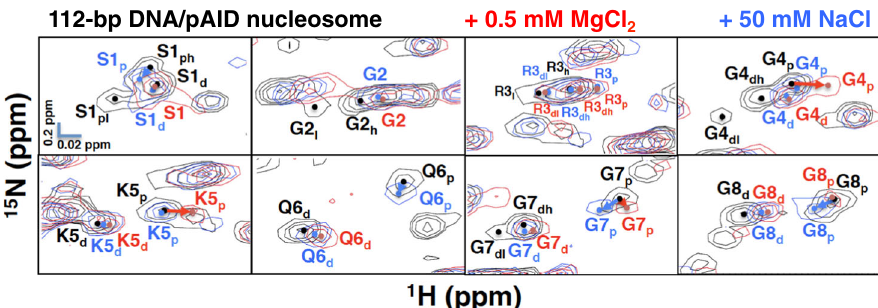
Fig. 7 Conformational comparison of the H2A N-tail upon metal ion titration. Expanded signal comparison of the H2A N-tail in the 112-bp DNA/pAID nucleosome at 0 M (black), 0.5 mM MgCl 2 (red), and 50 mM NaCl (blue). NMR signals are divided into panels by each amino acid residue, Ser1 – Gly8 of H2A. Signal assignments in the 112-bp DNA/pAID nucleosome at 0 M, 0.5 mM MgCl 2 , and 50 mM NaCl are labeled in black, red, and blue, respectively. Filled circles indicate each signal center. pAID and DNA side signals are designated by subscript p and d, respectively. High- and low- fi eld components of the signals are designated by subscript h and l, respectively. Arrows indicate chemical shift changes of pAID side signals between 0 mM and 0.5 mM MgCl 2 (red) or 50 mM NaCl nucleosome (Fig. 1b, c). These results indicate that the con- Under the physiological salt condition, the NS, BS1, and LS formational differences re fl ecting the asymmetric environments regions of the H2B N-tail (Glu2 – Lys15 and Asp25 – Lys27) of the tails arise from particular regions of H2A and H2B that dynamically interact with DNA and pAID in a similar manner show multiple interactions with DNA in the canonical (Supplementary Table 2), whereas the H2A N-tail and the BS2 nucleosome 33 . Therefore, the complicated behavior of the H2A region in the H2B N-tail interact more robustly with pAID than and H2B N-tails is markedly different from the simple behavior with DNA (Figs. 4d and 5c). We con fi rmed that these robust of the H3 N-tails, where most residues show two distinct con- interactions are important for nucleosome assembly with hFACT formations re fl ecting the pAID and DNA sides in the 112-bp (Fig. 6b, c). The functional conformation of the pAID side H2A DNA/pAID nucleosome 24 . and H2B N-tails (Fig. 8a) is explicitly different from that of the